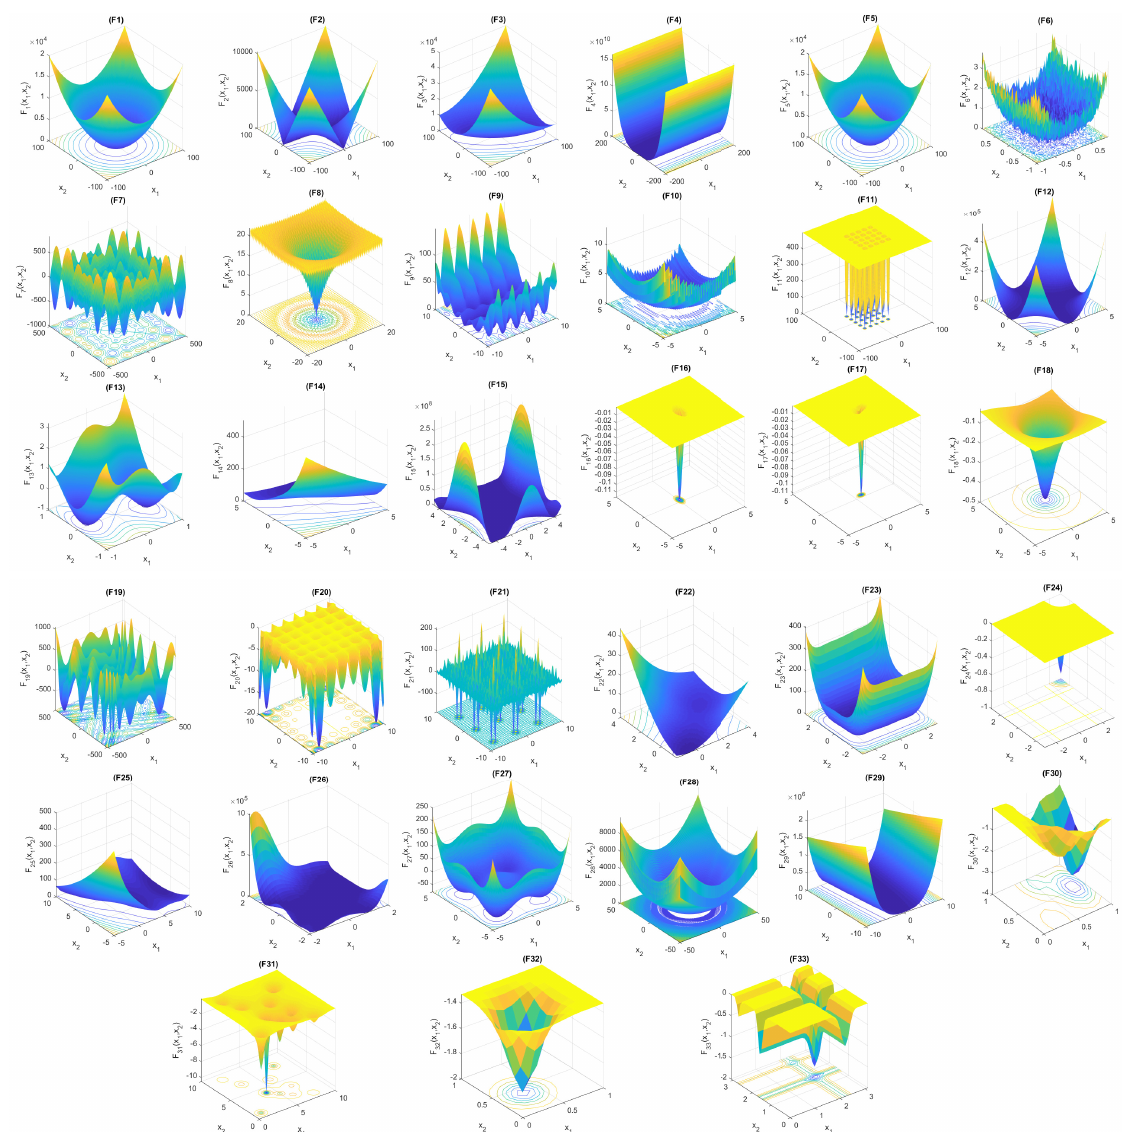
Figure 4. Search space plots of the benchmark